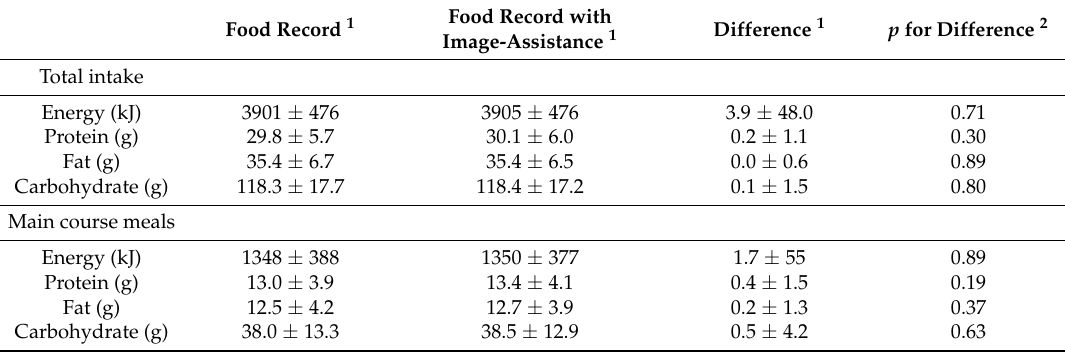
Table 2. Total daily energy and macronutrient intake, and the daily energy and macronutrient intake from the main course meals (lunch and dinner combined), estimated by regular five-day food records, and food records with image-assistance in the study infants ( n =